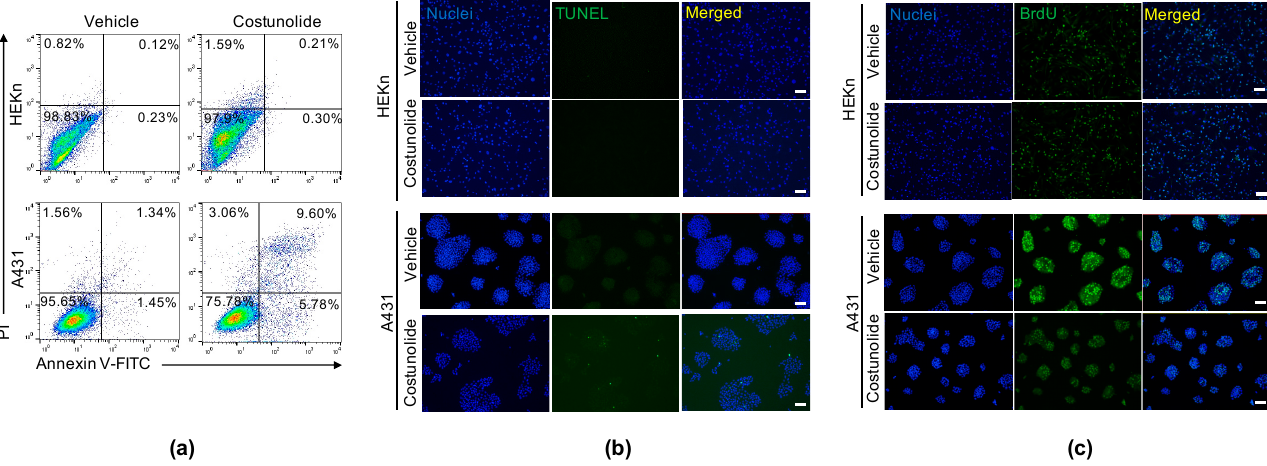
Figure 2. Effect of costunolide on apoptosis and proliferation in HEKn cells and A431 cells. HEKn cells and A431 cells were treated with costunolide (0.8 µM) for 48 h. ( a ) Apoptotic cell death was analyzed by Annexin V/PI staining. Cells were fixed and double stained with Annexin V and PI. Apoptotic cell (Annexin V+:PI- and Annexin V+:PI+) numbers were determined by flow cytometry. ( b ) The fragmented DNA of apoptotic cells was measured using the TUNEL assay. Cells were fixed and double stained with TUNEL and DAPI. Apoptotic cells were determined as green-stained cells under a fluorescence microscope. Scale bar = 100 µm. ( c ) Cell proliferation was determined by the BrdU incorporation assay. After 48 h costunolide treatment, cells were further incubated in BrdU containing culture medium for 2 h. Proliferating cells were identified as green-stained cells under a fluorescence microscope. Scale bar = 100 µm.